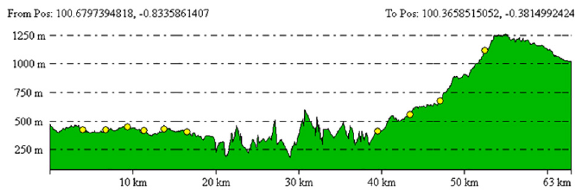
Figure 16. Longitudinal profile along the Semangko fault